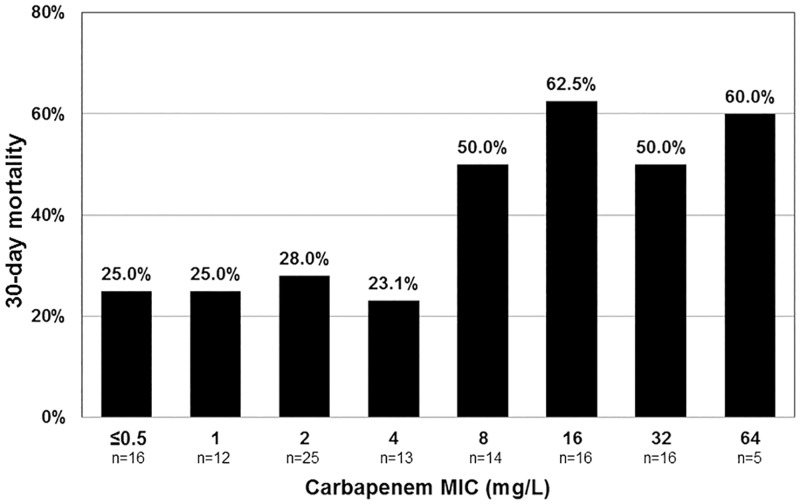
Thirty-day mortality rate of patients with Acinetobacter baumannii (Ab) group bacteremia in different susceptibility categories.The rate was significantly lower in those with carbapenem minimal inhibitory concentration (MIC) ≤ 4 mg/L comparing to those with carbapenem MIC ≥ 8 mg/L.